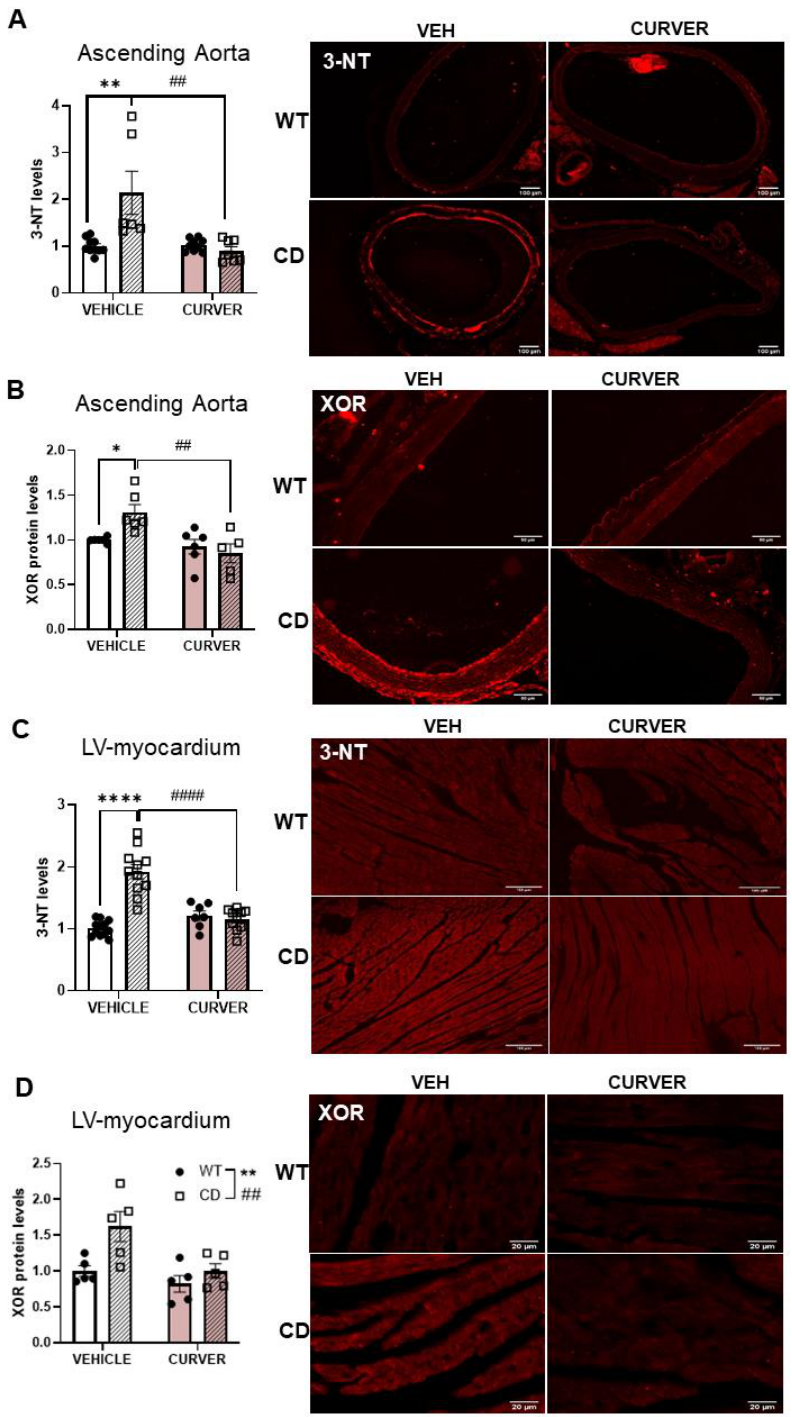
Figure 4. CURVER treatment reduces 3-NT and XOR aortic and cardiac levels in CD mice. ( A ) Rep- resentative images of 3-NT immunodetection in ascending aortas. Quantitative analysis showed a significant reduction in CURVER-treated versus CD-vehicle mice ( p = 0.0007). ( B ) A significant in- crease in XOR protein levels occurs in the ascending aorta of CD-vehicle mice which were prevented following CURVER treatment ( p = 0.5591). ( C ) In LV-myocardium, we observed a significant genotype/treatment interaction F (1, 36) = 39.09 p < 0.0001) for 3-NT levels. ( D ) A significant increase in XOR protein levels of CD mice (effect of genotype, F (1, 16) = 8.653, p = 0.0096) was reduced after CURVER treatment (effect of treatment, F (1, 16) = 8.725, p = 0.0093). * Effect of genotype; #, effect of treatment. * p < 0,05; **, ## p < 0.005; ****, #### p <